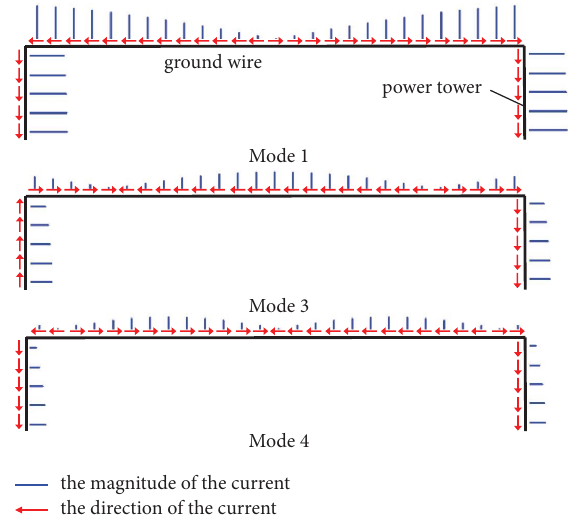
Figure 7: Te distribution of characteristic mode current for resonant modes on the PTL. Note: the length of the blue line represents the magnitude of the current at the wire segments, and the currents of the resonant modes use the same normalization